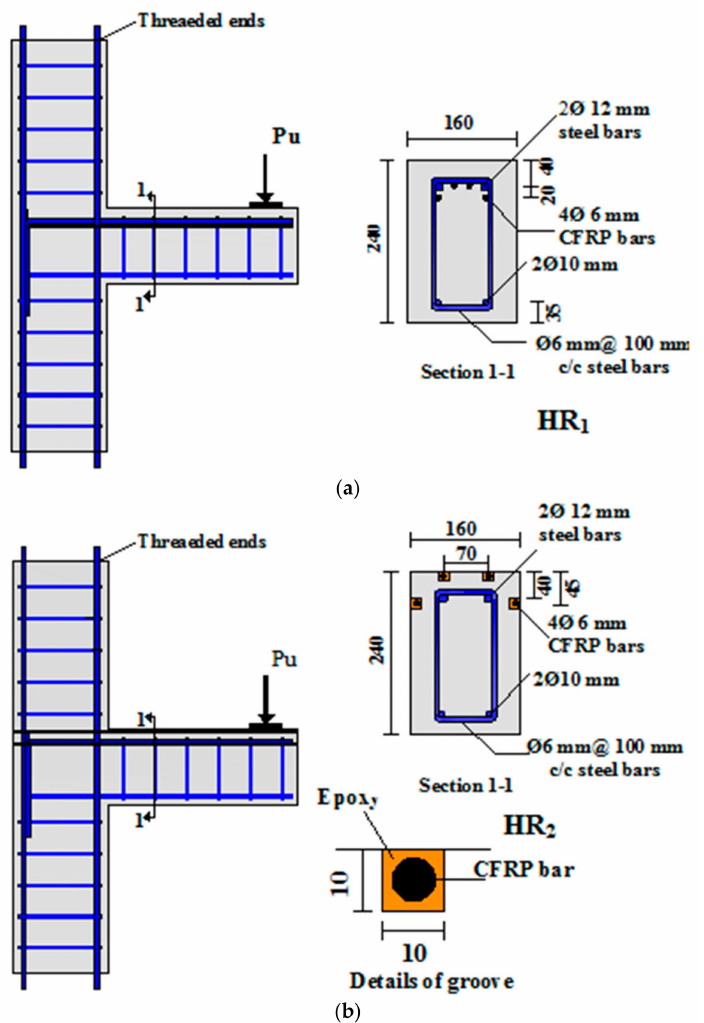
Figure 3. Details of specimens in Group(II) and Group(III) (BCJs with hybrid reinforcement